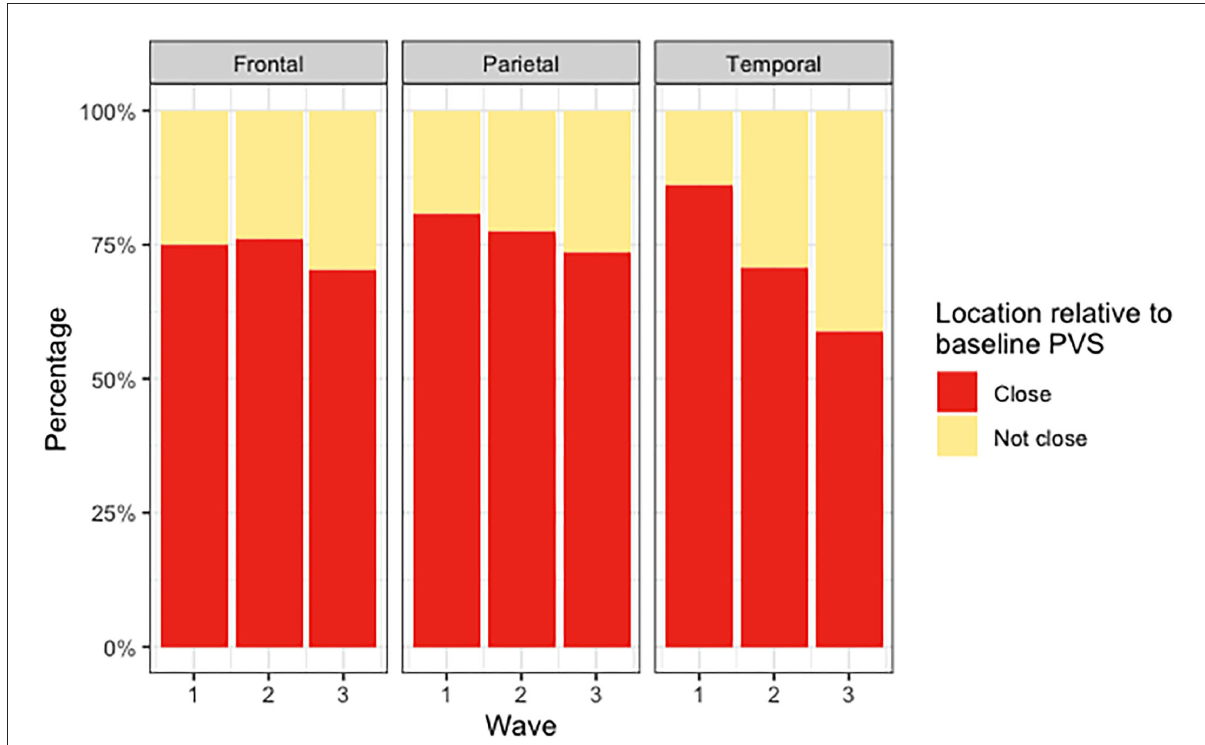
FIGURE7 Percentages of deep WMH in waves 1, 2, and 3 that were found close and not close to baseline PVS in the frontal, parietal, and temporal regions.